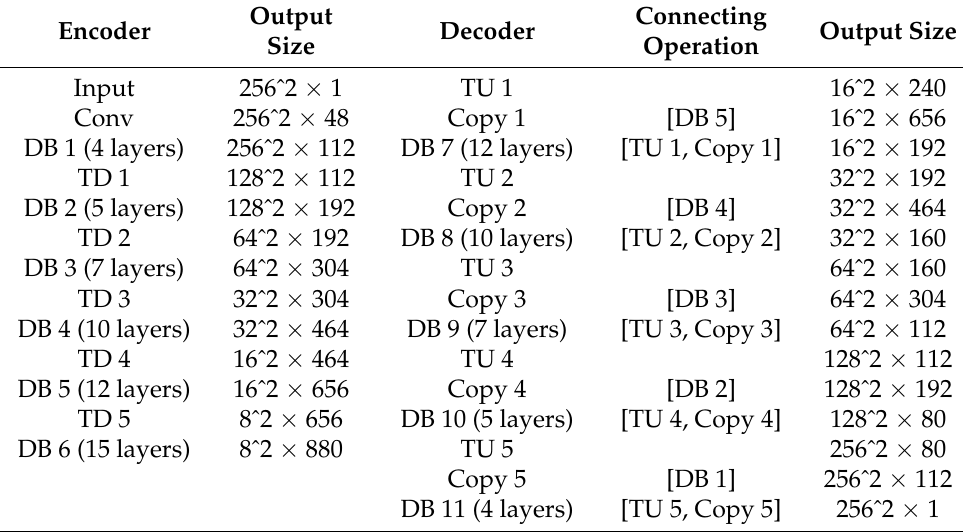
Table 2. Architecture of SED-2 (Conv. stands for convolution, UP means up-sampling, [ ] denotes long range connection, [ ˆ ] denotes superscript, and [ , ] denotes concatenate